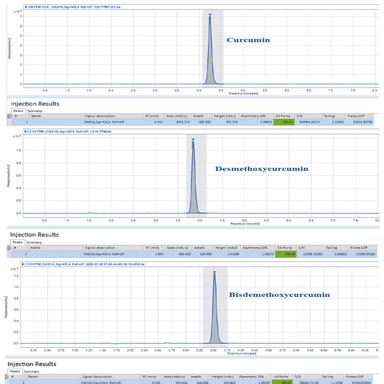
HPLC-DAD chromatograms of pure curcumin, desmethoxycurcumin and bisdemethoxycurcumin with their percent purities.